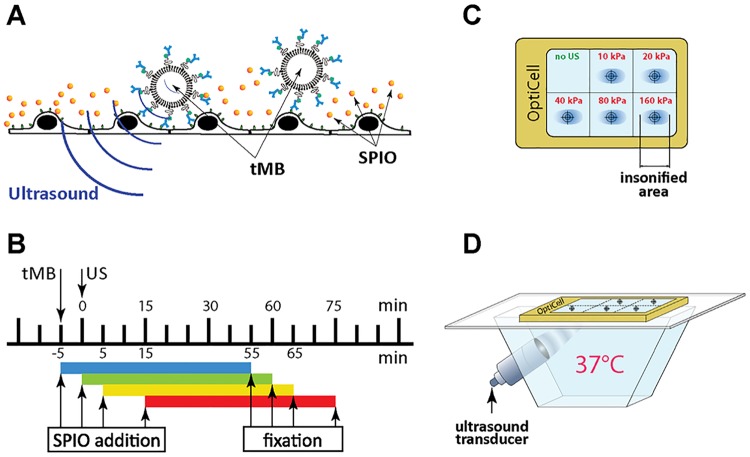
Experimental setup.(A) Schematic representation of the tMB adhering to HUVECs during treatment. (B) Timing diagram of the experiment. The time of insonification (0 min) was used as the reference time. Targeted microbubbles (tMB) were added 5 min before the ultrasound was applied; SPIO was added 5 min before (i.e. -5 min), just before (i.e. 0 min), 5 min after, and 15 min after insonification. Cells were fixated 60 min after SPIO addition. (C) Scheme of insonification of subsections of the OptiCell™ chamber (to scale). The acoustic pressure is given in PNP. (D) The treatment setup.